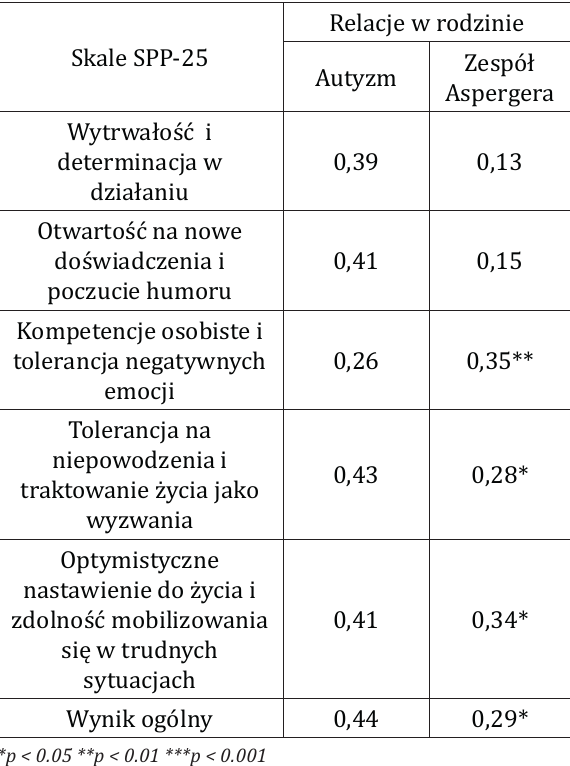
Tabela 7. Współczynniki korelacji obliczone między oceną relacji w rho-Spearmana (tabela 7). rodzinie a zdolnościami adaptacyjnymi mierzonymi Skalą